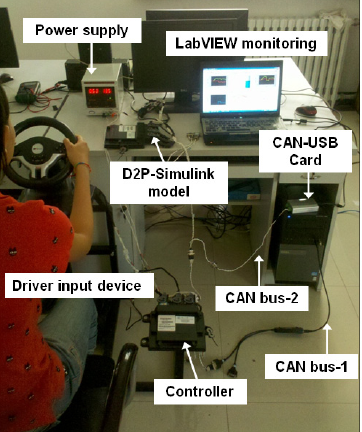
Figure 8. Driver-in-the-loop experiment platform.